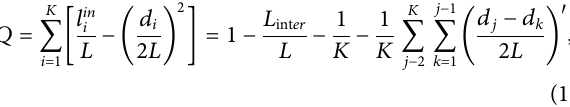
Frontiers in Physics |